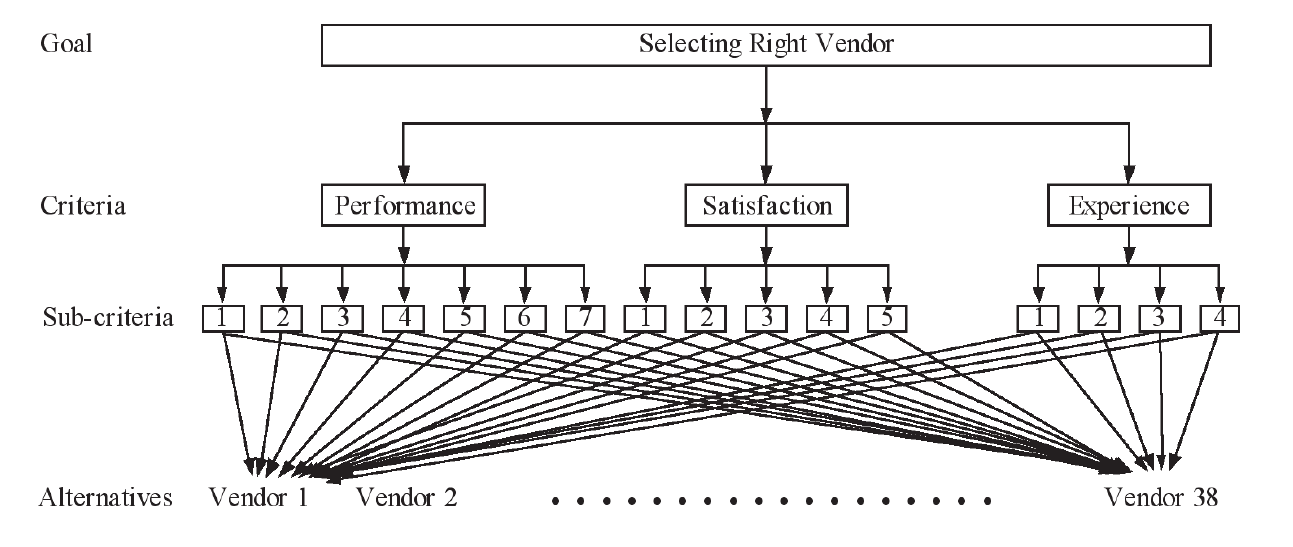
Figure 2: Hierarchy of